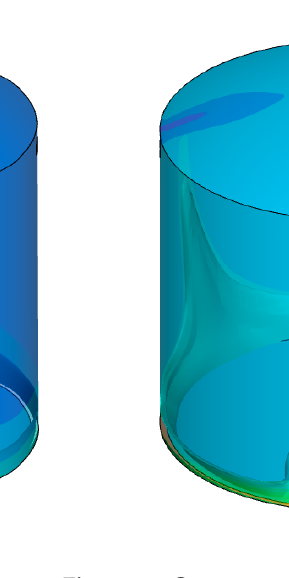
( h ) Figure 16. Distribution of n-hexane vapors (mass fraction) in the IFRT at different floating-deck heights. ( a ) Wind speed = 4.36 m·s–1, floating-deck height = 2.82 m. ( b ) Wind speed = 6.36 m·s –1 , floating-deck height = 2.82 m. ( c ) Wind speed = 6.36 m·s –1 , floating-deck height = 5.63 m. ( d ) Wind speed = 4.36 m·s –1 , floating-deck height = 5.63 m. ( e ) Wind speed = 6.36 m·s –1 , floating-deck height = 8.45 m. ( f ) Wind speed = 4.36 m·s –1 , floating-deck height = 8.45 m. ( g ) Wind speed = 6.36 m·s –1 , floating- deck height = 9.98 m. ( h ) Wind speed = 4.36 m·s –1 , floating-deck height = 9.98 m. The n-hexane-vapor emission from the IFRT was also investigated; the floating-deck height was at 9.98 m, wind speed 4.36 m·s − 1 , and the concentration distribution as depicted in Figure 17. It can be seen that the n-hexane vapors discharged from the vents on the front and rear sides of the tank were diffused along the wind direction and that the vapors discharged from the leeward-side vent spread around the vent. Irrespective of the front and rear sides or the leeward side of the tank (the vent on the windward side is the airflow inlet), the mass fraction of n-hexane vapors near the vents reached 0.002, and such high concentration of vapors discharged into the atmosphere do not meet environmental safety requirements and will cause air pollution. Therefore, if equipping the vents with an oil-vapor-recovery unit is necessary, priority should be given to the above-mentioned three vents. Figure 17. Distribution of n-hexane-vapor concentration (mass fraction) near the vents. 4. Conclusions The evaporative loss rates of n-hexane in the IFRT model and the wind speeds of gas space above the floating deck inside the tank were measured using wind-tunnel experiments and also simulated using ANSYS Fluent software. The conclusions drawn from the research results can be summarized as follows: Figure 16. Distribution of n-hexane vapors (mass fraction) in the IFRT at di ff erent floating-deck heights. ( a ) Wind speed = 4.36 m · s − 1 , floating-deck height = 2.82 m. ( b ) Wind speed = 6.36 m · s − 1 , floating-deck height = 2.82 m. ( c ) Wind speed = 6.36 m · s − 1 , floating-deck height = 5.63 m. ( d ) Wind speed = 4.36 m · s − 1 , floating-deck height = 5.63 m. ( e ) Wind speed = 6.36 m · s − 1 , floating-deck height = 8.45 m. ( f ) Wind speed = 4.36 m · s − 1 , floating-deck height = 8.45 m. ( g ) Wind speed = 6.36 m · s − 1 , floating-deck height = 9.98 m. ( h ) Wind speed = 4.36 m · s − 1 , floating-deck height = 9.98 m.